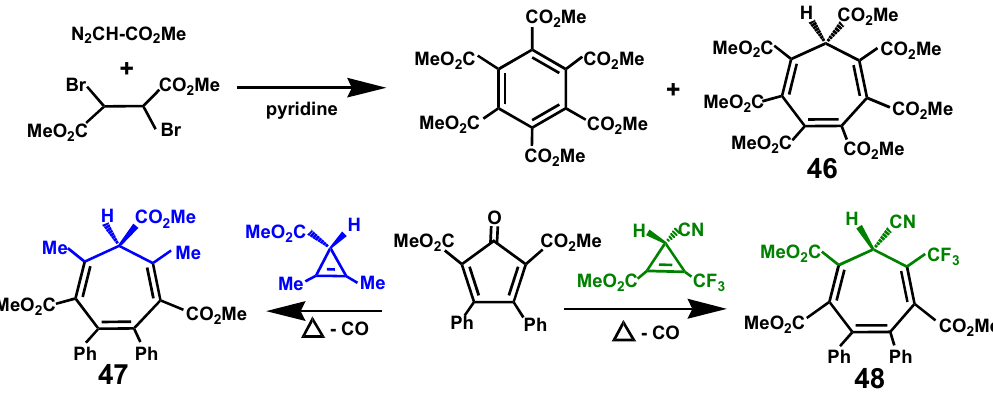
Scheme 18. Diels-Alder reactions of cyclopentadienones and cyclopropenes bearing multiple electron-withdrawing